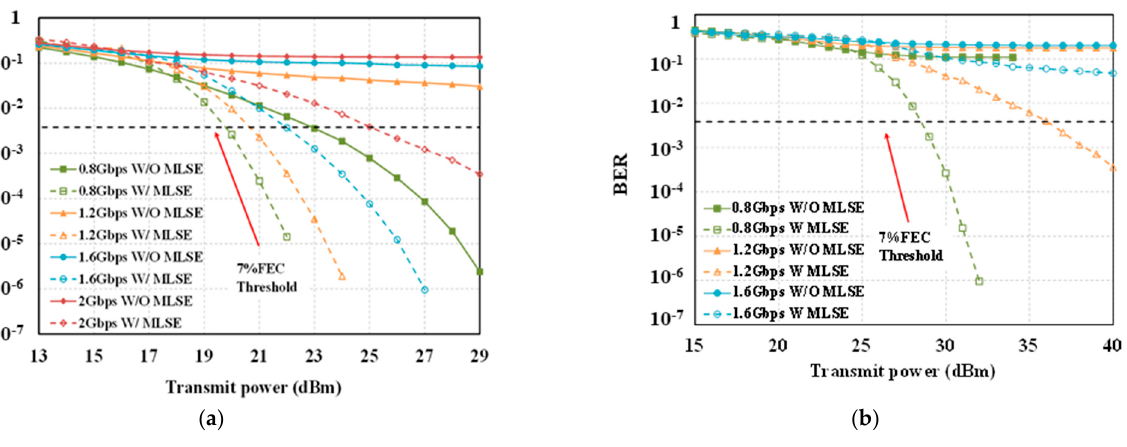
Figure 12. ( a ) 8 m transmission distance’s BER performance versus transmit power with PAM4 modulation in harbor water with 30° FOV. ( b ) 10 m transmission distance’s BER performance versus transmit power with PAM4 modulation in harbor water with 30° FOV.